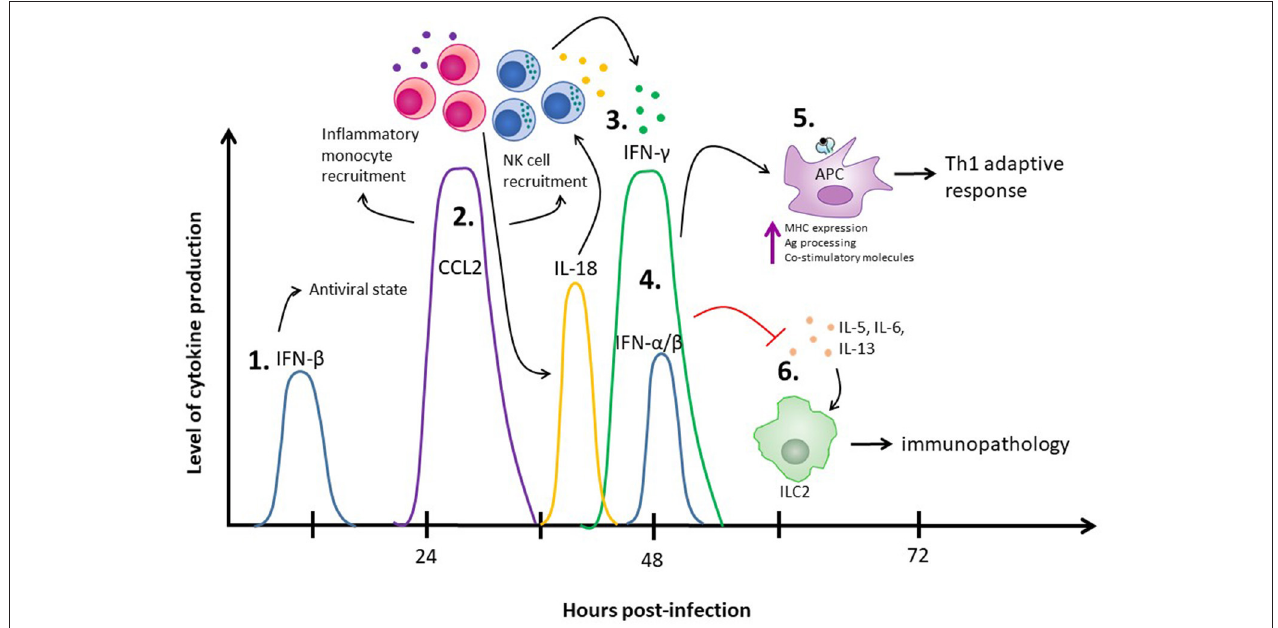
FIGURE 1 | The role of IFNs in the innate immune response to HSV-2 infection. (1) IFN- β is produced at 12h post-infection and through autocrine and paracrine signaling places surrounding cells into an antiviral state. (2) The IFN- β produced at 12h post-infection also increases production of CCL2 between days 1 and 2 post-infection, which results in inflammatory monocyte recruitment and has been implicated in NK cell recruitment. (3) The recruited inflammatory monocytes result in release of IL-18, which stimulates NK cells to produce IFN- γ at 48h post-infection. (4) A second wave of type I IFNs, including both IFN- α and IFN- β , are detected at 48h post-infection. (5) Both IFN- γ and the type I IFNs produced at 48h post-infection enhance APC antigen presentation capacities to stimulate a Th1 adaptive immune response. (6) Simultaneously, the type I IFNs at 48h inhibit ILC2-mediated virus-induced immunopathology. IFN- γ , supporting the negative regulatory effects of type I IFN, also suppresses ILC2-mediated